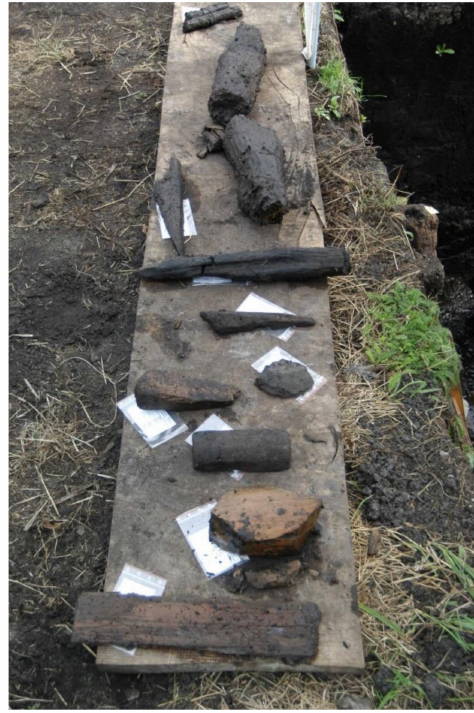
Figure 3. Wood samples excavated at Bruszczewo